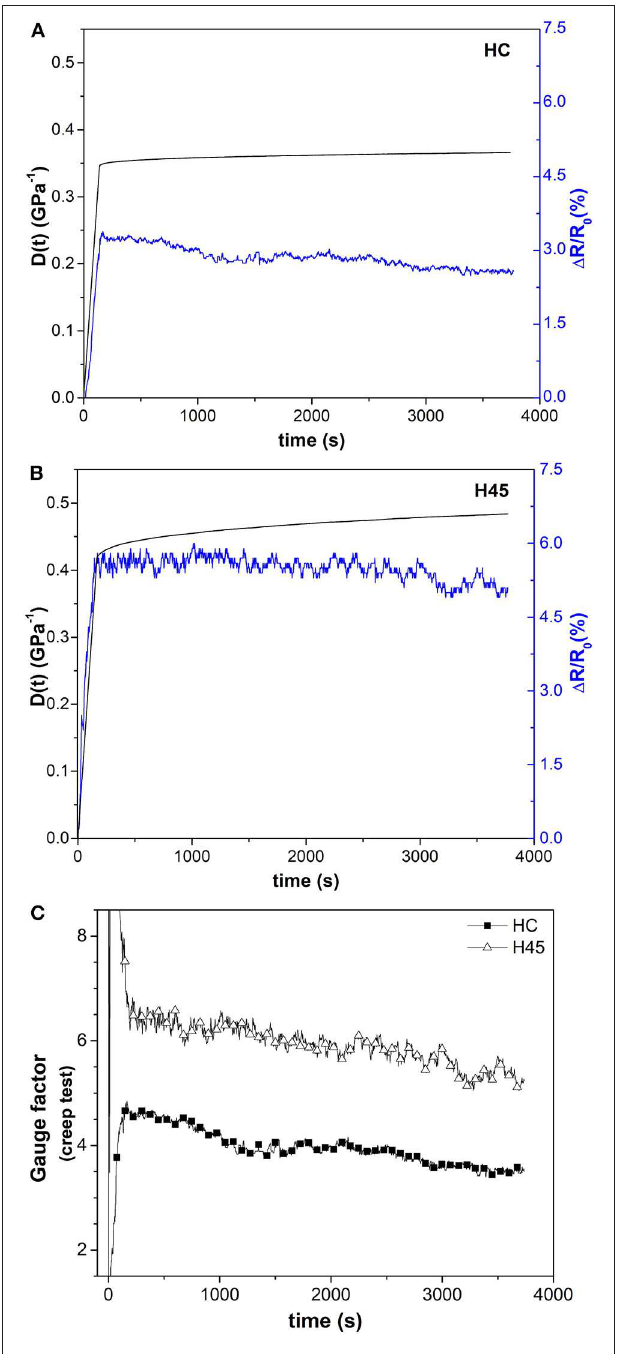
FIGURE 8 | Creep compliance at a constant stress of 20 MPa and 1 R/R0 for different infill samples: (A) HC and (B) H45. Gauge factor evolution during creep test (C)